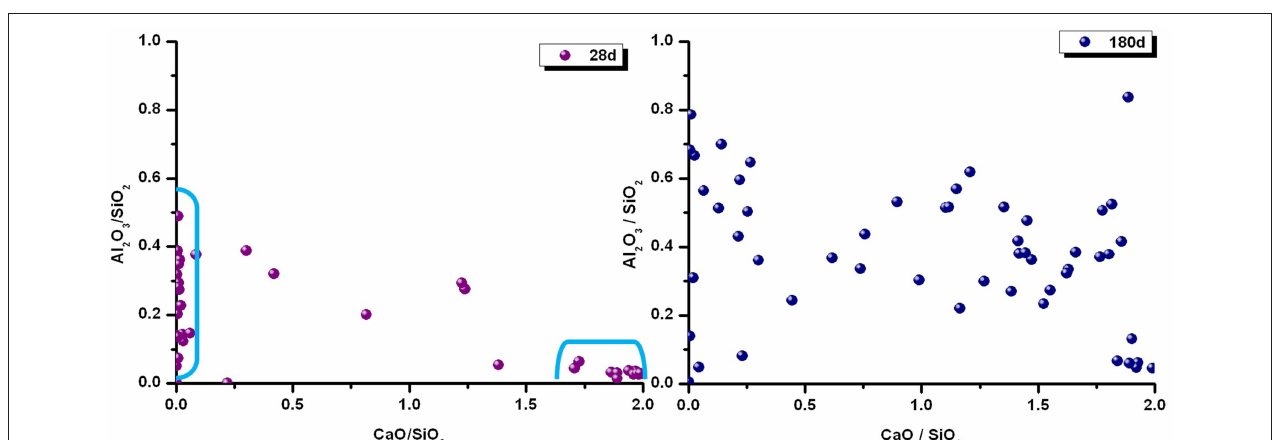
FIGURE 7 | CaO/SiO 2 and Al 2 O 3 /SiO 2 ratios calculated from the microanalysis of 28 d and 180 d hybrid cement